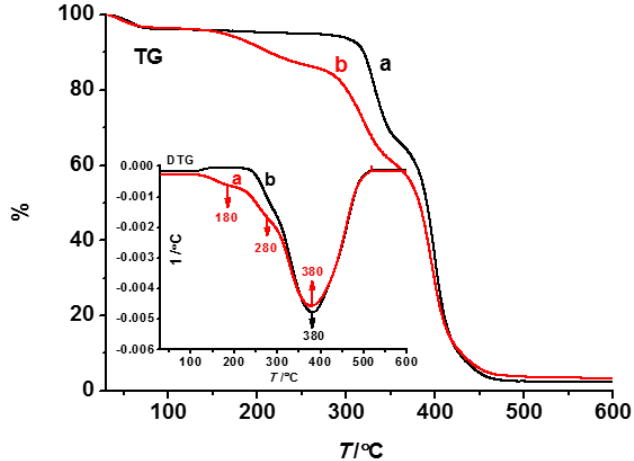
Figure 5. TG-DTG curves of nanofibers (( a ) before elution (red line); and ( b ) after elution (black line)).